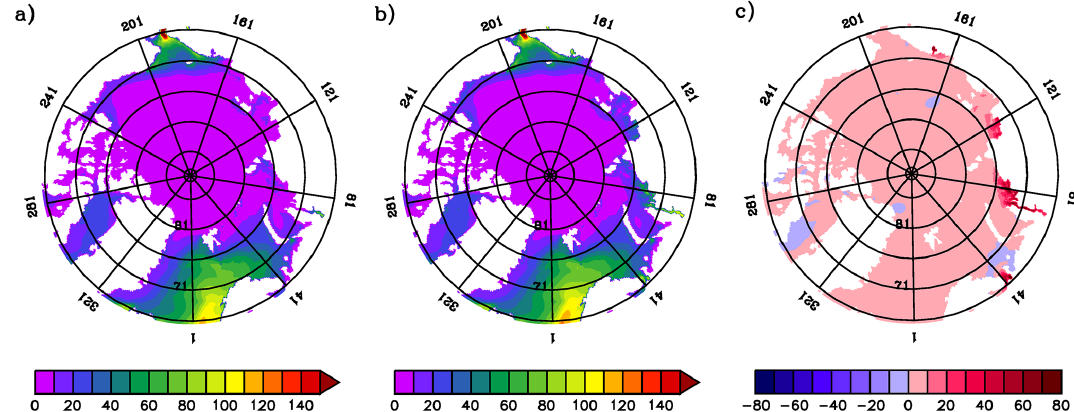
Figure 2. Mean annual ocean primary production (gCm − 2 ) over 1998–2011 (a) without RDON removal by bacterioplankton (CTRL run) and (b) with RDON removal by bacterioplankton (RIV run), and (c) the absolute difference (gCm − 2 ; RIV run – CTRL